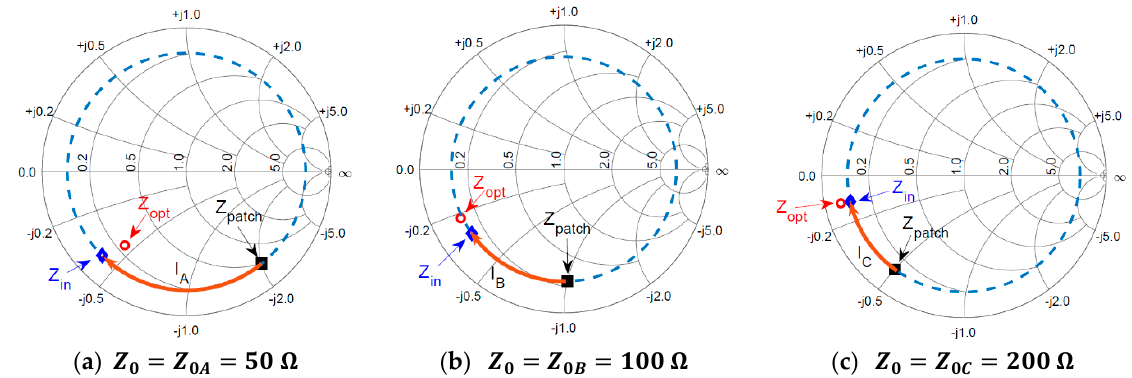
Figure 6. The same antenna input impedance normalized with respect to three different characteristic impedances Z 0 A , Z 0 B , Z 0 C . In each case, the Z opt impedance is also